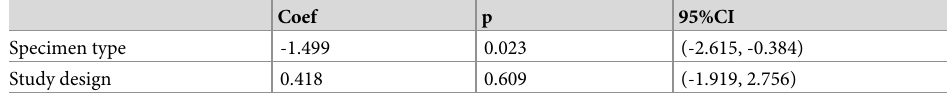
Table 2. Possible sources of heterogeneity in the meta-regression analysis.